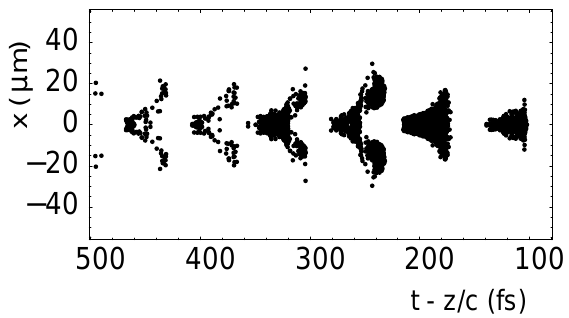
FIG. 9. Real space snapshot at 3.0 mm for a 2 nC bunch.